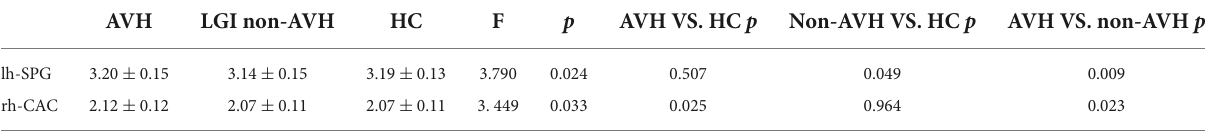
TABLE 4 Comparisons of LGI among three